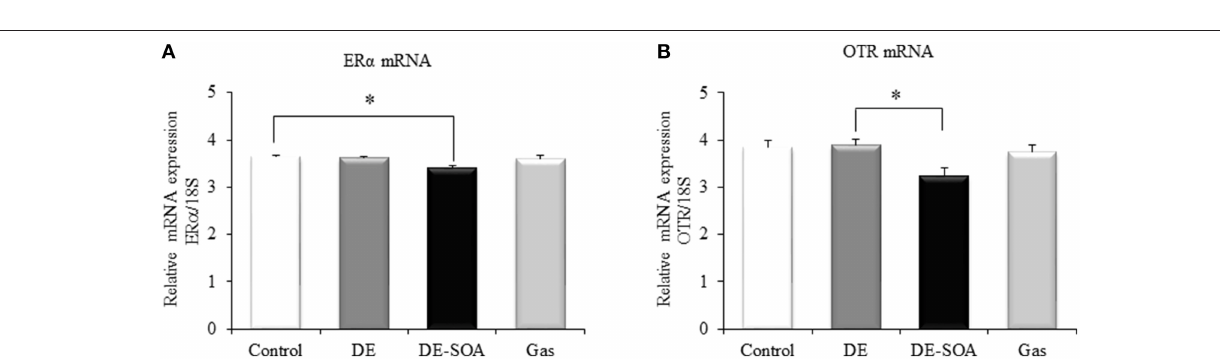
FIGURE 2 | Hypothalamic expression of social behavior-related genes. Messenger RNA expression level of (A) ER α and (B) OTR in the hypothalami of 13 week-old male mice after developmental period exposure to clean air, DE, DE-SOA or gas without particles. Each bar represents the mean ± SE ( n = 12 , * P < 0.05